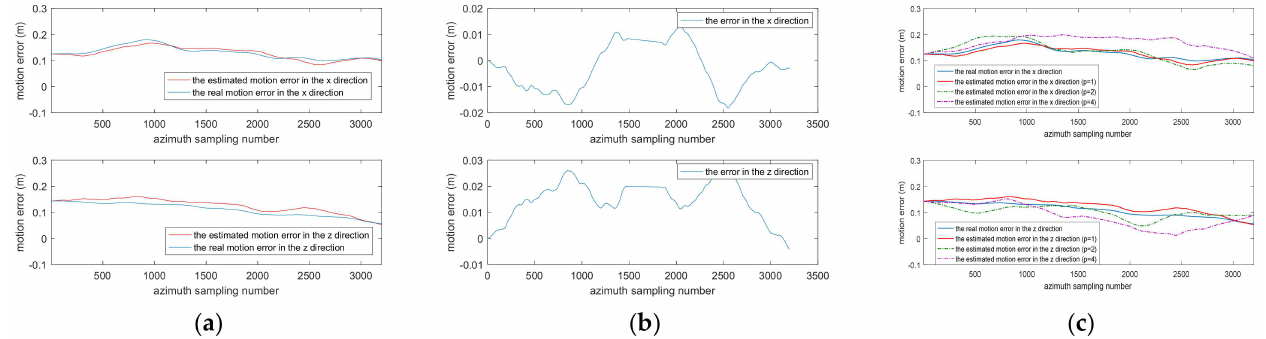
Figure 13. ( a ) Motion error estimation results when p = 1 (airborne SAR data experiments); ( b ) Error estimation of motion errors when p = 1 (airborne SAR data experiments); ( c ) Comparison results of motion error estimation when p = 1, 2, 4 (airborne SAR data